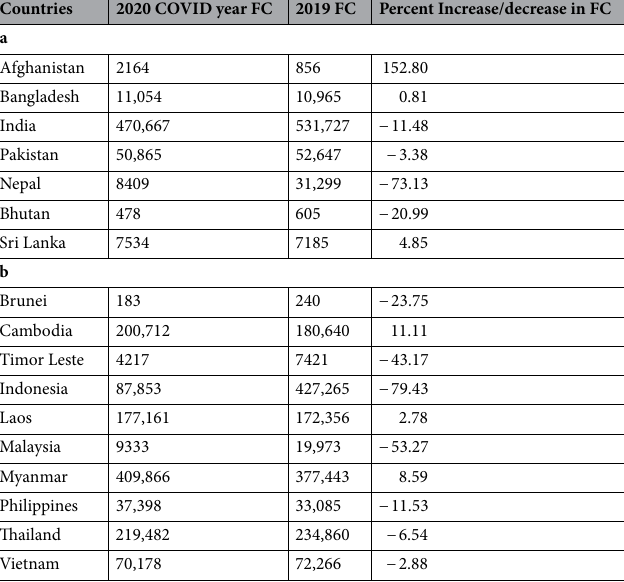
Countries 2020 COVID year FC 2019 FC Percent Increase/decrease in